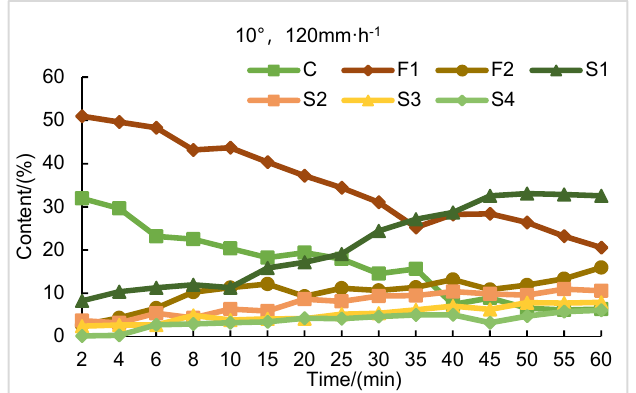
Figure 3. Variation characteristics of the eroded sediment particle size with the rainfall duration.